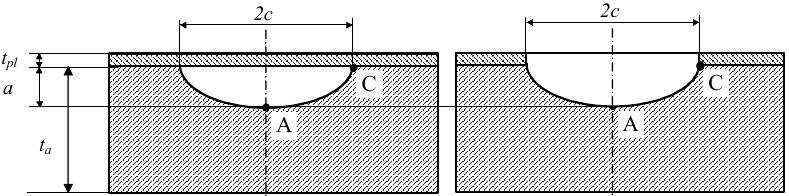
Figure 4: The two crack types defined for Fracture Mechanics analyses [6,